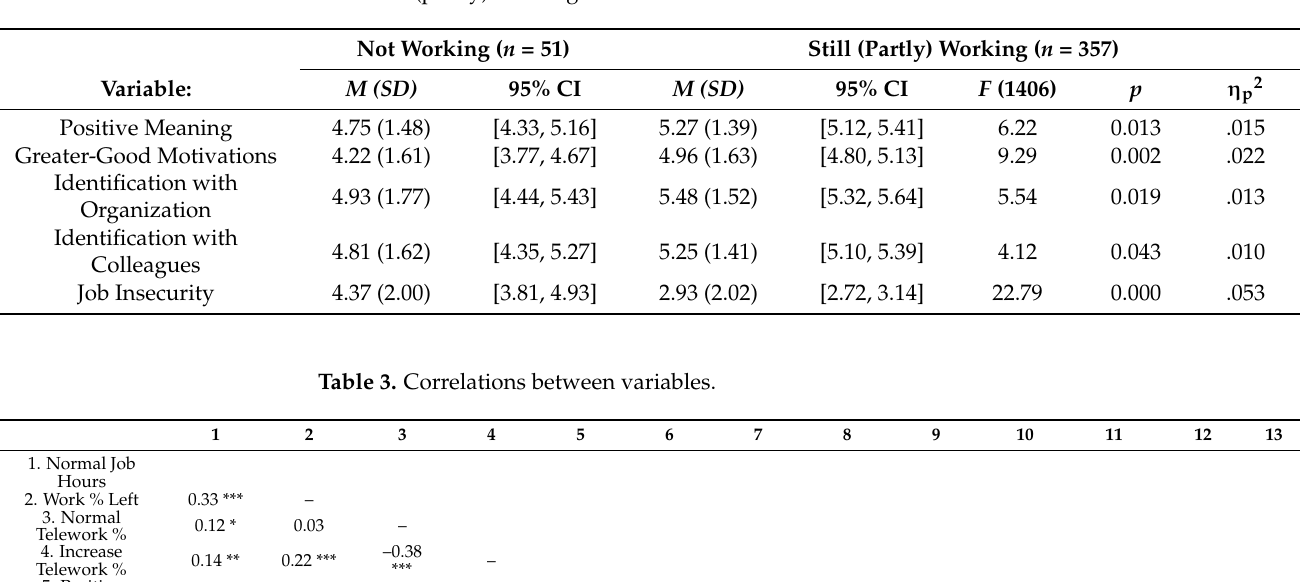
Table 2. Differences between employees who were not working during lockdown and those who were still (partly) working.